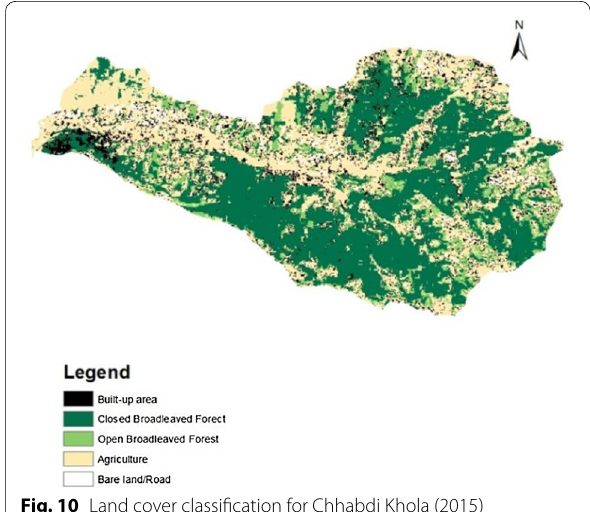
Fig. 10 Land cover classification for Chhabdi Khola (2015)